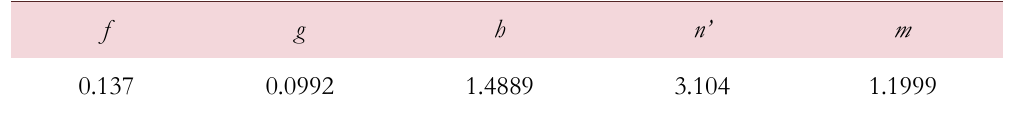
Table 4: Identification of anisotropic coefficients and a shape coefficient m